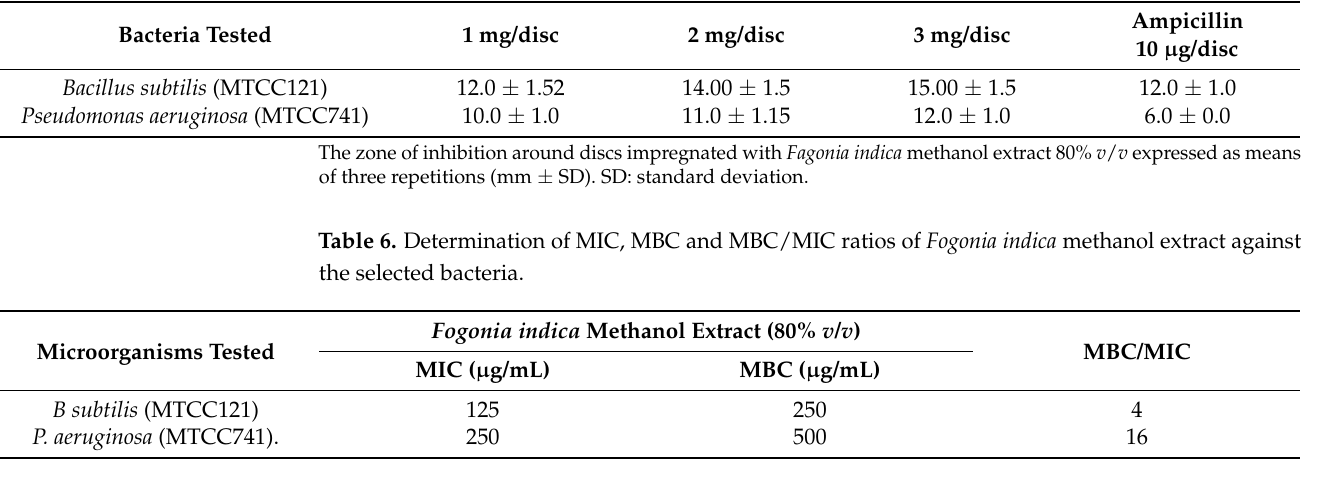
Table 5. The inhibition zone of methanol extract of Fagonia indica expressed as means of three repetitions (mm + SD).